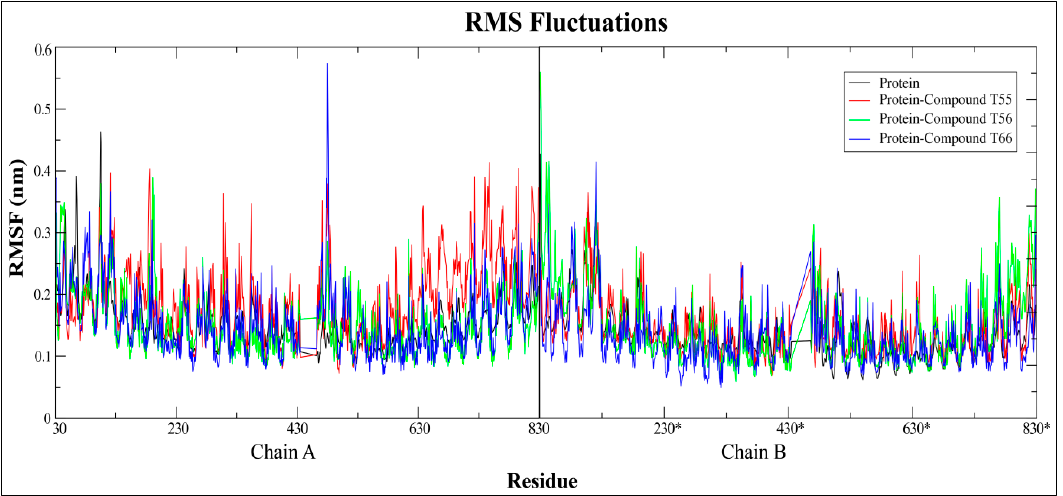
Figure 20. Root mean square fluctuations plot of native TLR7 protein and protein–ligand complex over 10 ns simulation run. * represents the residues of chain B of the homodimeric protein